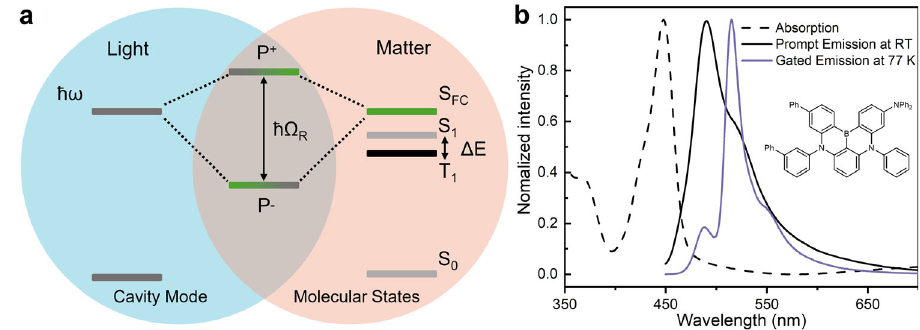
Fig. 1 Strong coupling system for realizing S 1 – T 1 energy inversion. a Jablonski diagram presenting the energy gap ( Δ E ) between fi rst excited singlet (S 1 ) and triplet (T 1 ) states. Strong coupling of the Frank – Condon state (S FC ) with a resonant cavity mode ( ħ ω ) leads to the formation of two hybrid light-matter states, P + and P – , which are separated in energy by the Rabi splitting ( ħ Ω R ). b Absorption (dashed black), prompt emission (solid black, at rt) and gated emission (purple, 100 ns gate delay, at 77 K, delayed fl uorescence at ~490 nm and phosphorescence at 515 nm) spectra of a neat